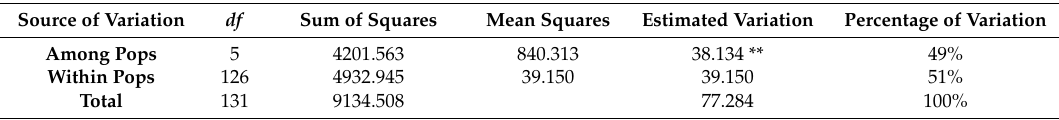
Table 2. Analysis of molecular variance for wild cotton accessions among and within six populations as identified by STRUCTURE.